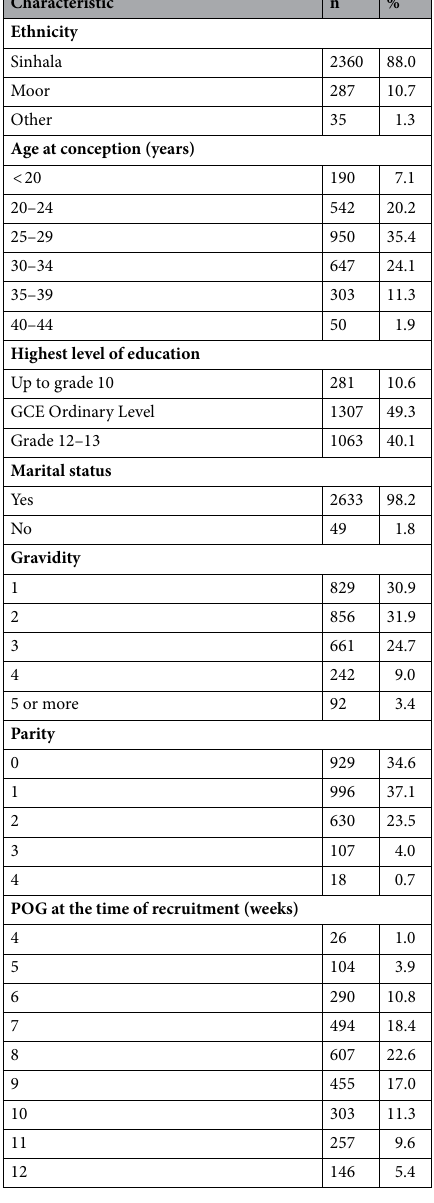
Table 1. Characteristics of the study population. GCE general certificate of education, POG period of